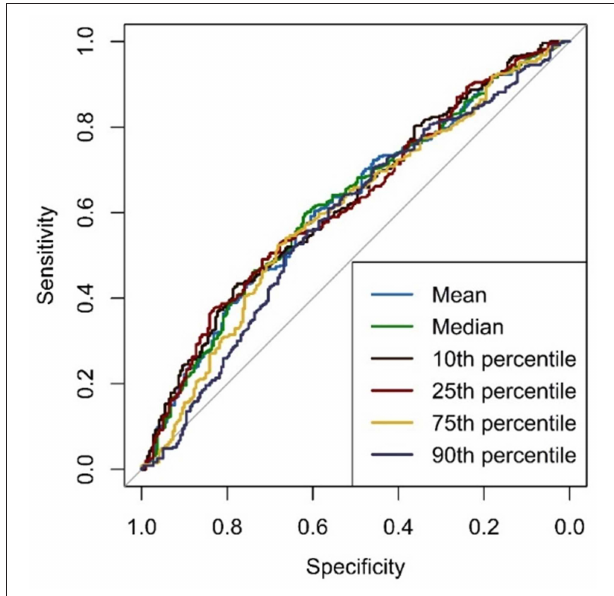
FIGURE 6 | ROC curves of APTw histogram parameters from MS lesions (MSL) and white matter hyperintensities of presumed vascular origin (WMH).